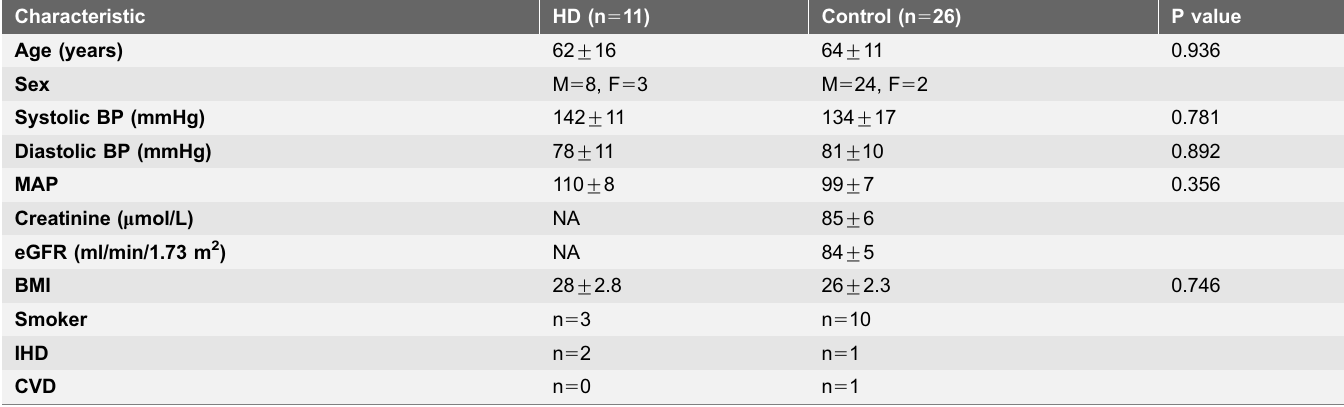
Values are Mean ¡ SEM. P value indicates the comparison between the groups by t-test, and the significance at P , 0.05. Abbreviations : eGFR, estimated glomerular filtration rate; BP, blood pressure; MAP, main arterial pressure; BMI, body mass index; IHD, ischemic heart disease; CVA, cerebrovascular accident; NA, not available; NS,